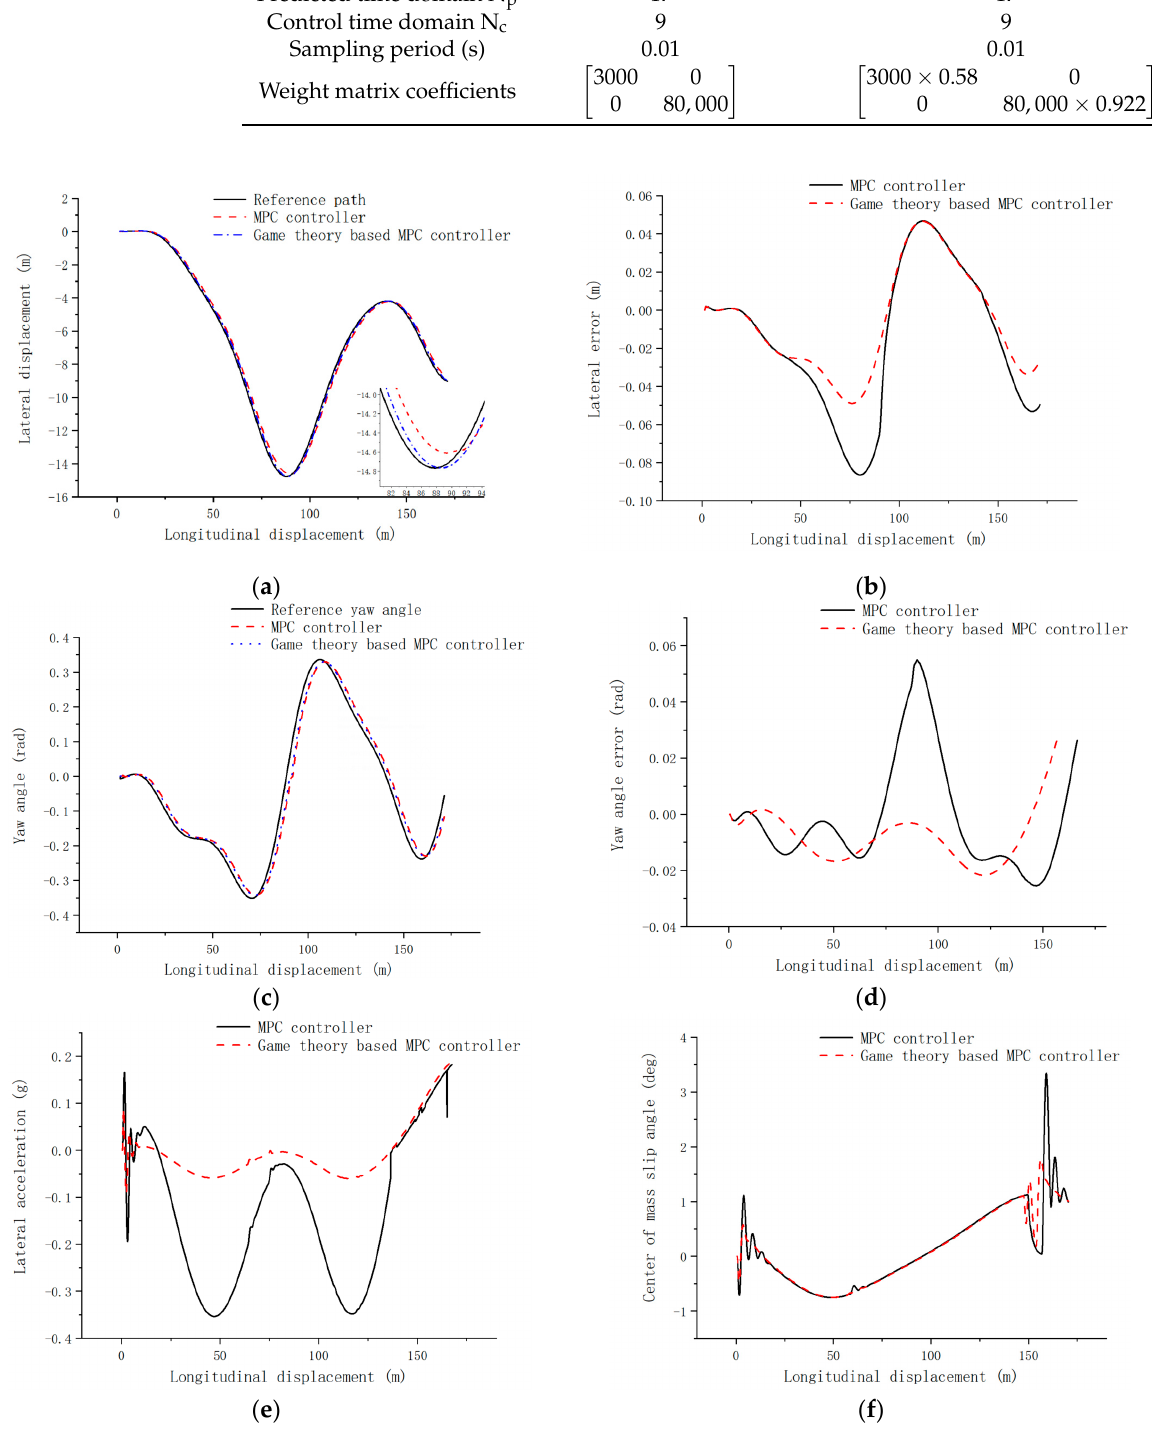
Figure 5. Simulation comparison of the two controllers at a speed of 30 km/h. ( a ) Comparative diagram of lateral displacement; ( b ) comparative diagram of lateral error; ( c ) comparative diagram of yaw; ( d ) comparative diagram of yaw angle error; ( e ) comparative diagram of lateral acceleration; ( f ) comparative diagram of center of mass slip angle.